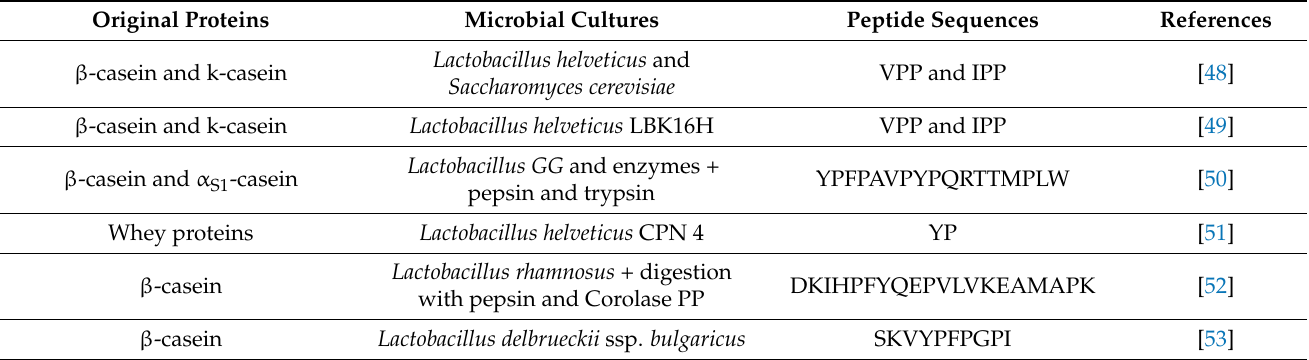
Table 2. Cardioprotective peptides derived from milk using fermentation proteolytic